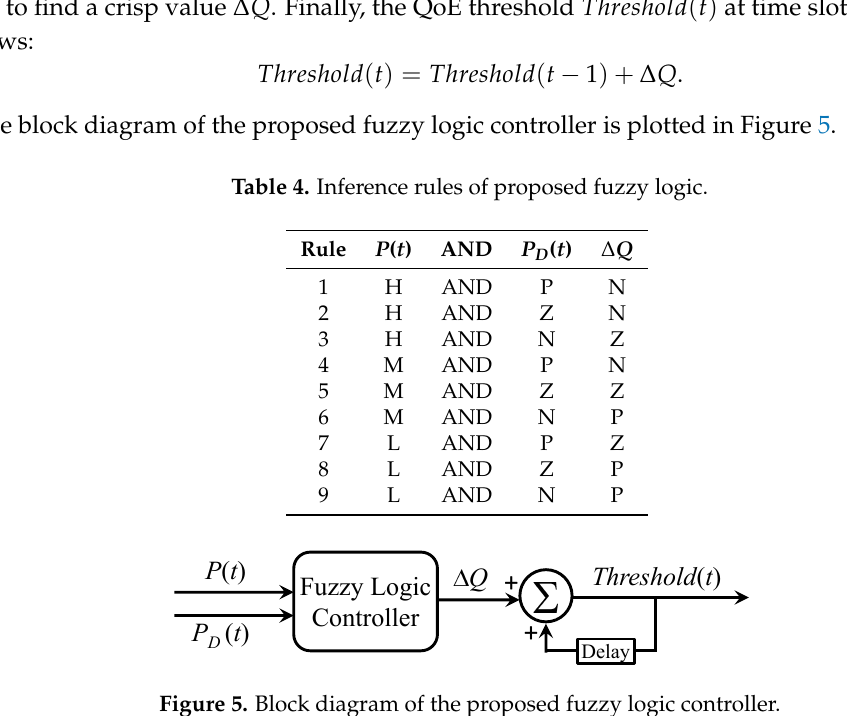
Figure 5. Block diagram of the proposed fuzzy logic